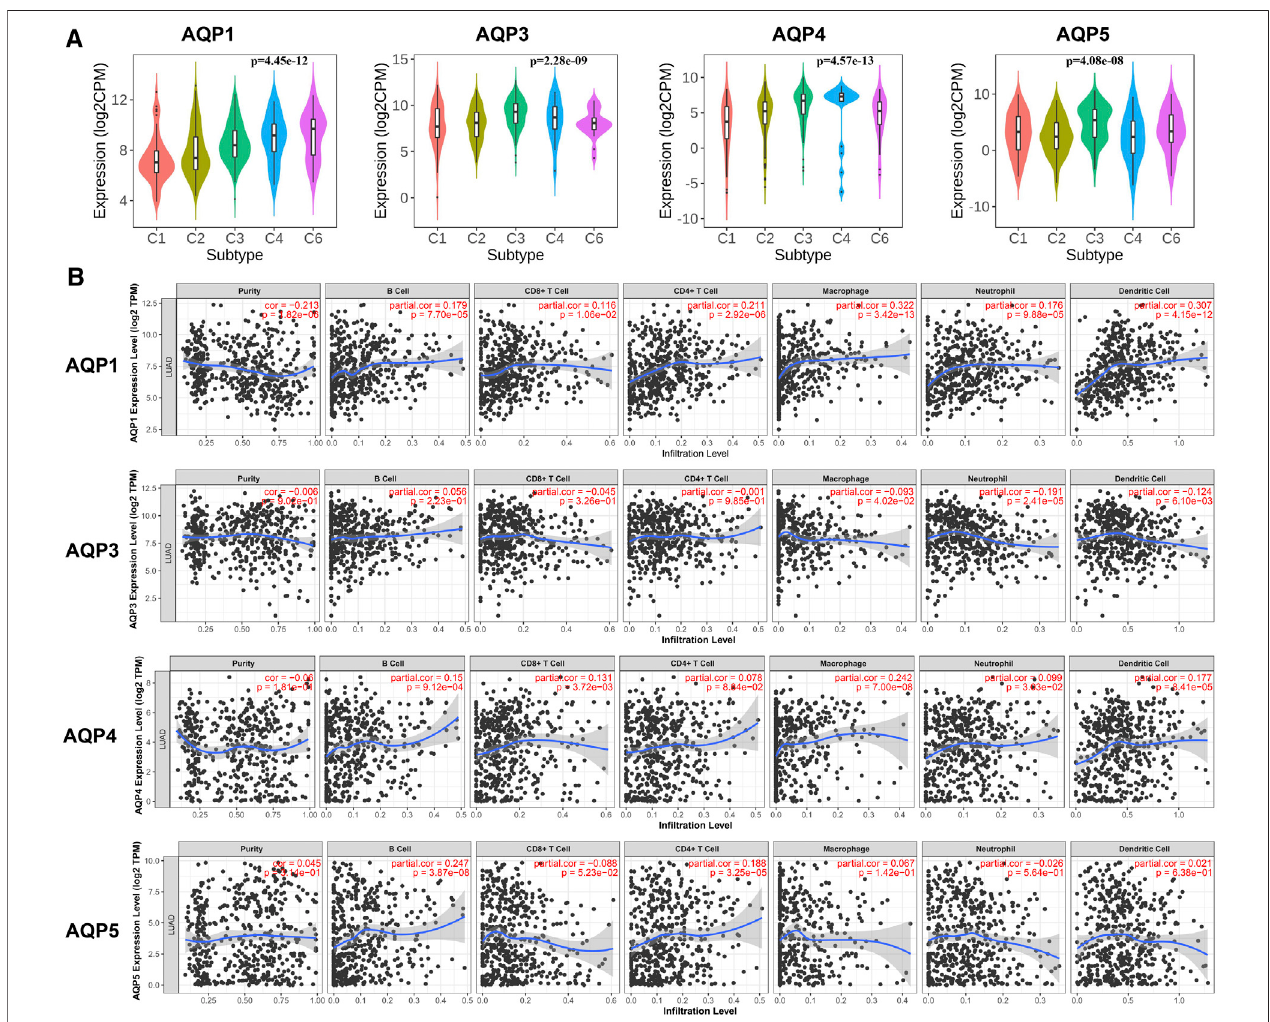
FIGURE 6 | Correlations between immune in fi ltration and AQPs in LUAD. (A) TISIDB was conducted to assess the relationship between expression of four AQPs and tumor-in fi ltrating lymphocytes. (B) Relationship between AQP expression and immune in fi ltration level generated from TIMER.